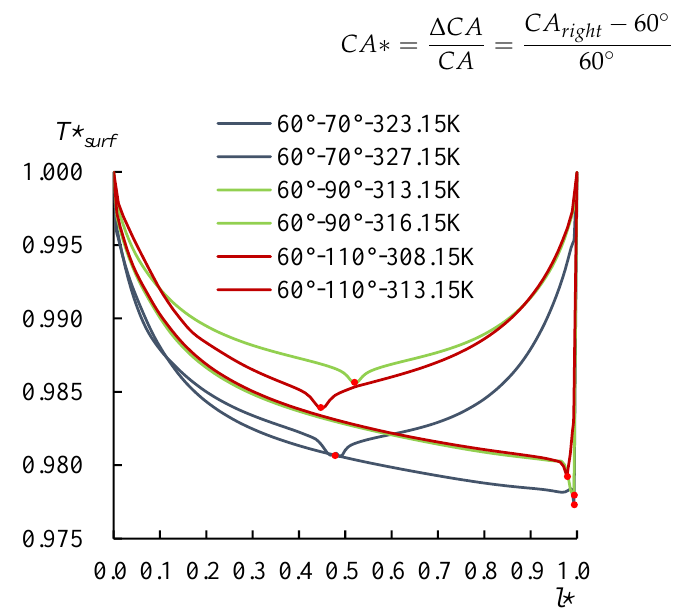
Figure 17. The temperature distribution along the LA interface of non-spherical droplets (60° – 70°, 60° – 90°, and 60° – 110°). With the increase of the CA on the right side, the critical temperature for the formation of the single-vortex flow was reduced.